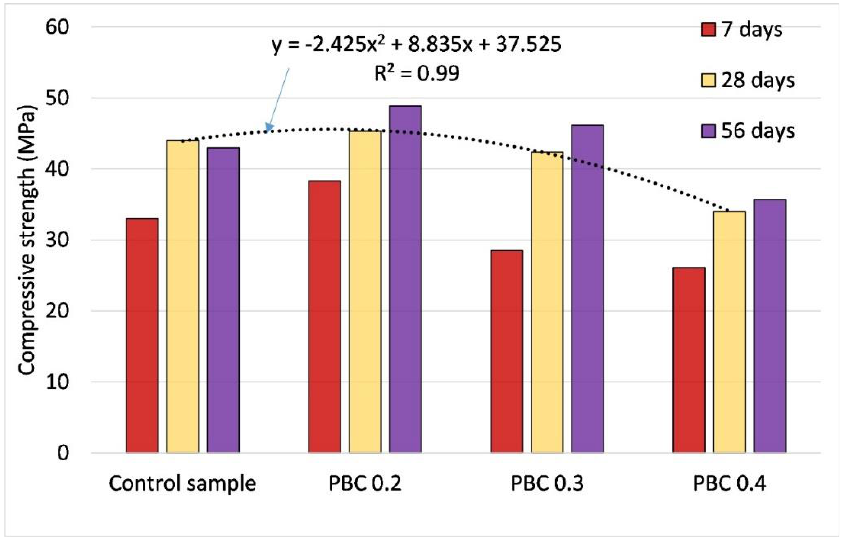
Figure 6. Compressive strength of CCF IPB at 7, 28 & 56 days (Trendline for 28 days). SLS 1425 defines four classes based on compressive strength, whereas no such specification is provided in BS EN 1338. Based on 28 days of strength, paving blocks with CR content of 5% and 10% satisfy class 4 requirements, and blocks with CCF of 0.2% and 0.3% satisfy class 2 requirements, according to SLS 1425. IS 15658 specifies compressive strength values to be within 30 – 55 MPa. ASTM recommends a relatively higher value (55.2 MPa) for the required compressive